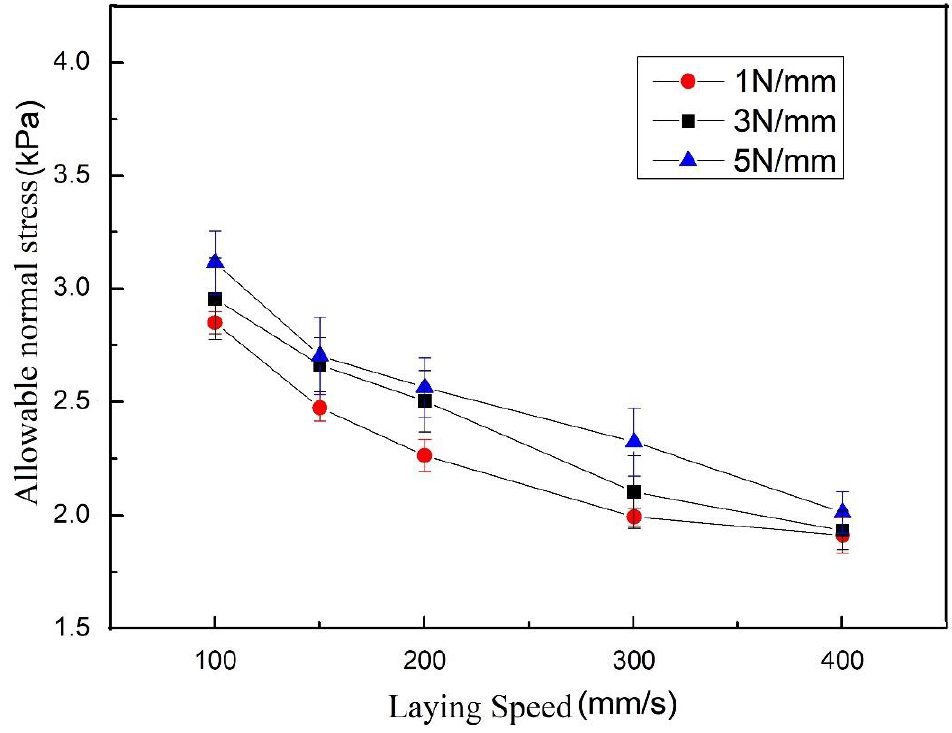
Figure 13. Laying speed/allowable normal stress curve of prepreg/prepreg laminate.